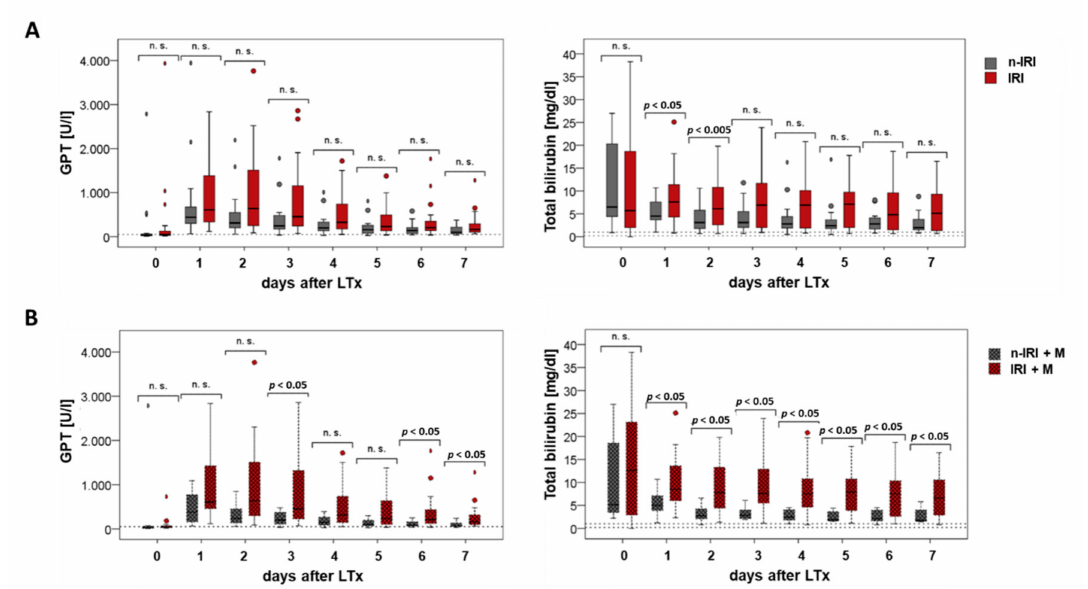
Figure 2. Recipient-GPT and total bilirubin pre-operative (post-operative day (POD) 0) and on PODs 1–7: comparison between patients with an existing or absent IRI ( A ) and between patients with a marginal transplant and an existing or absent IRI ( B